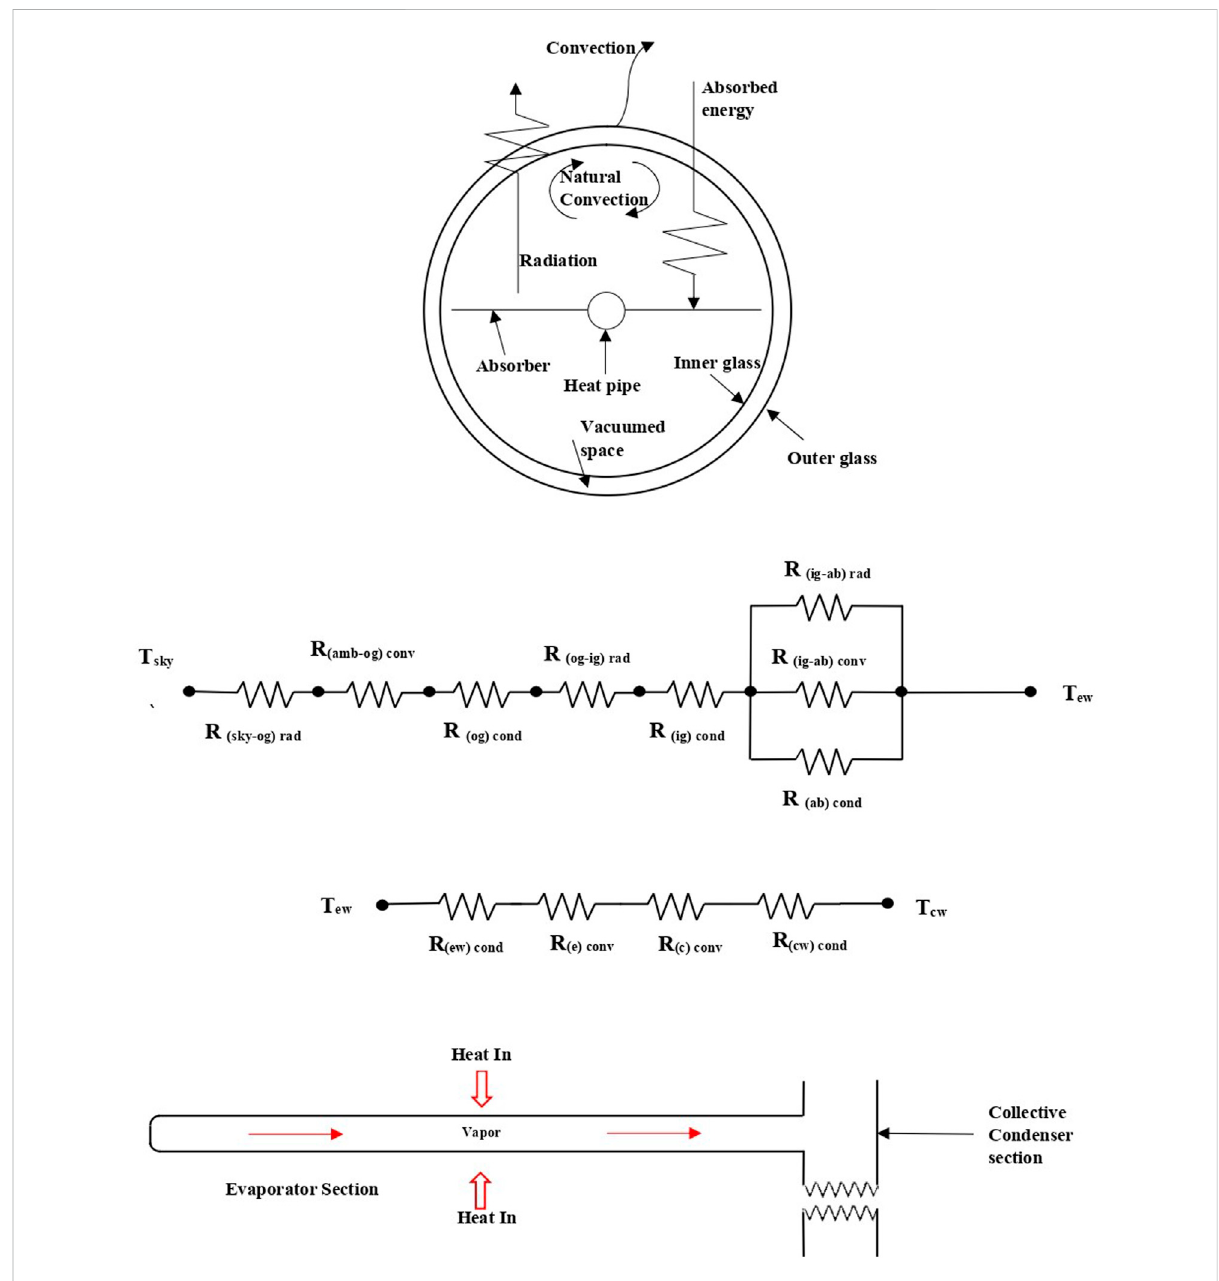
FIGURE 3 Thermal energy balance and resistance in the ETSC-CCHPSD